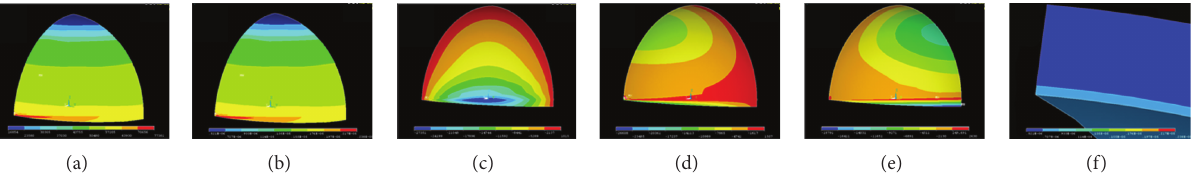
Figure 6: The stress and strain distribution considering viscoelasticity of human skull and dura mater. (a) Stress nephogram, (b) strain nephogram, (c) XY shear stress nephogram, (d) XZ shear stress nephogram, (e) YZ shear stress nephogram, and (f) interbedded strain change nephogram in the human dura mater and skull.